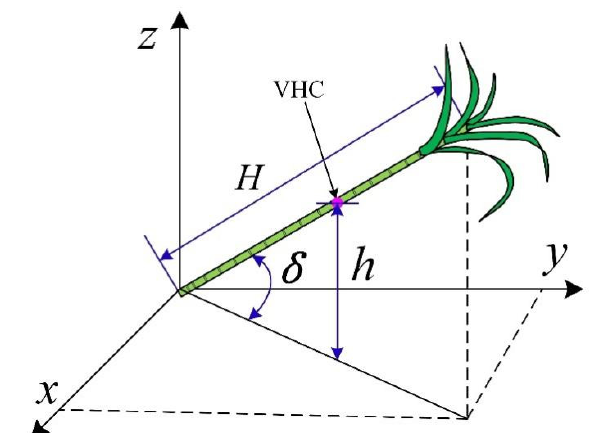
Figure 4. Calculation of VHC.